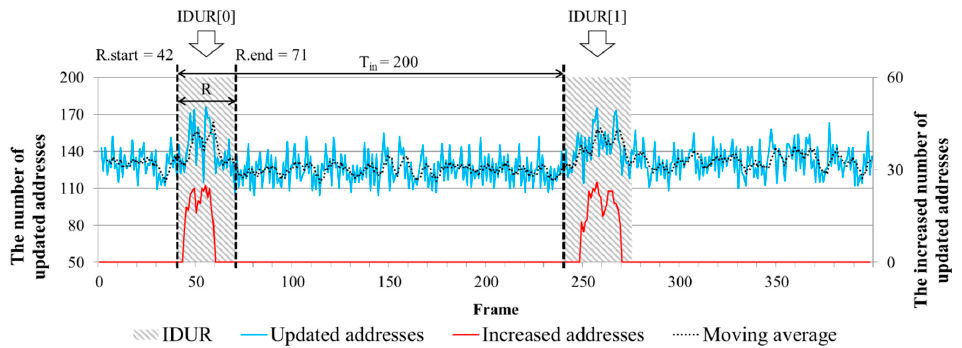
Figure 7. Identification of Input-Driven Updated Range.